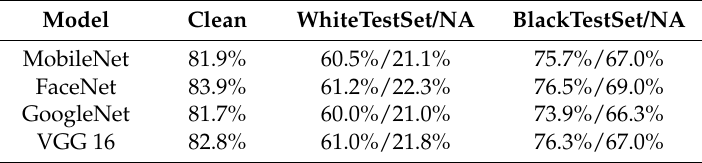
Table 5. Accuracy of model using our proposed